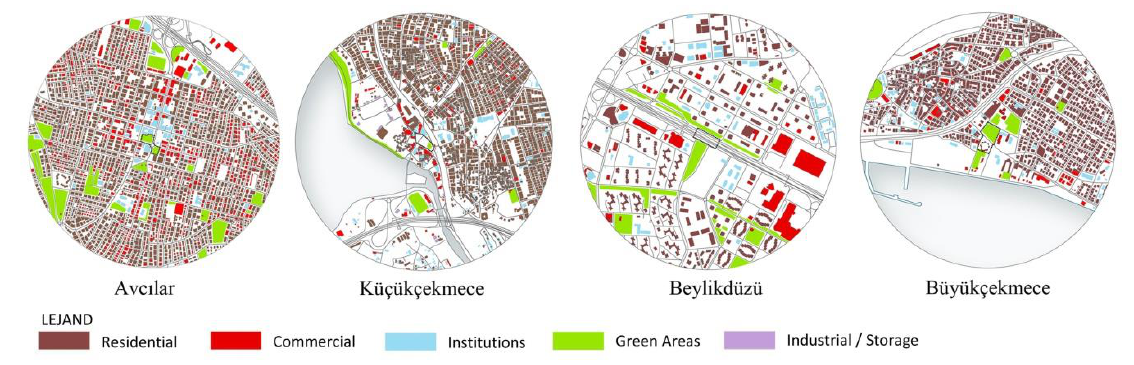
Figure 5 Land-use compositions within the square-areas (800 meter circular